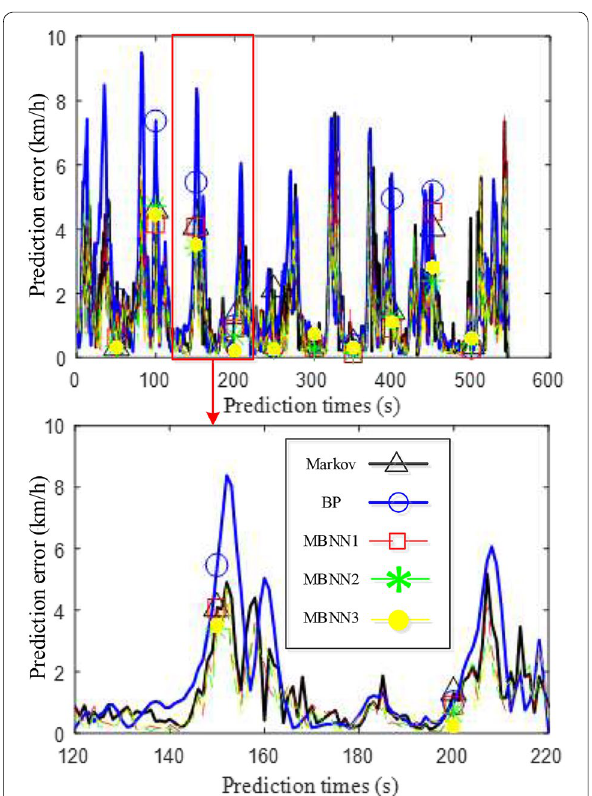
Figure 18 Vehicle speed prediction error for 5s prediction